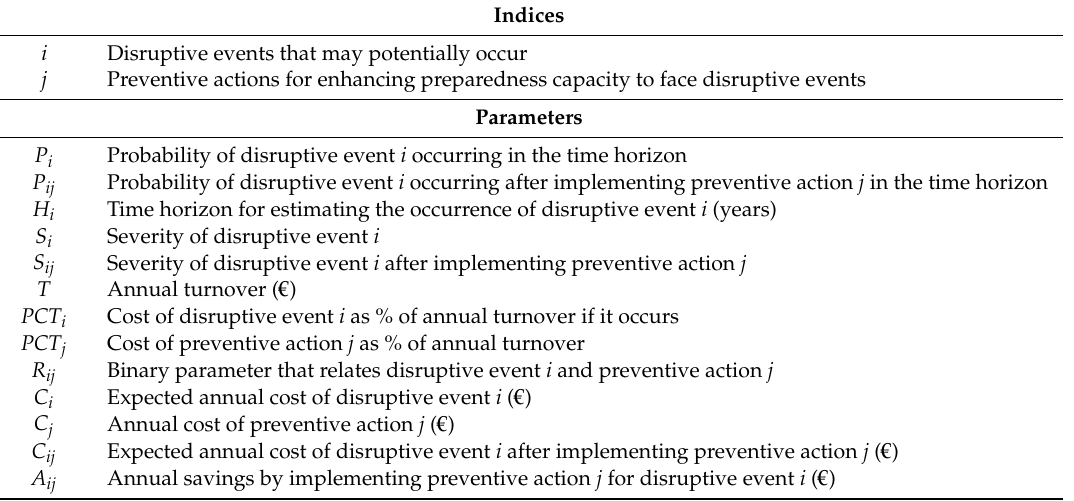
Table 5. Nomenclature of mixed-integer linear programming (MILP)